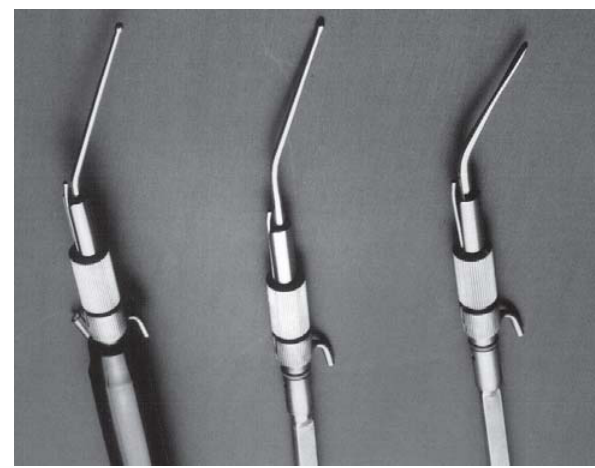
Fig. 2 - Sondas de endarterectomia do aparelho KUE (King Ultrasonic